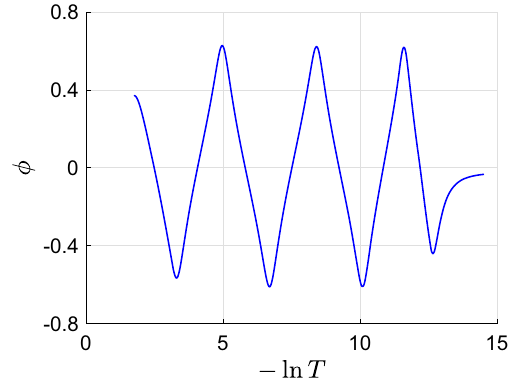
Fig. 1 φ vs. − ln T at the center. T is the proper time for a central